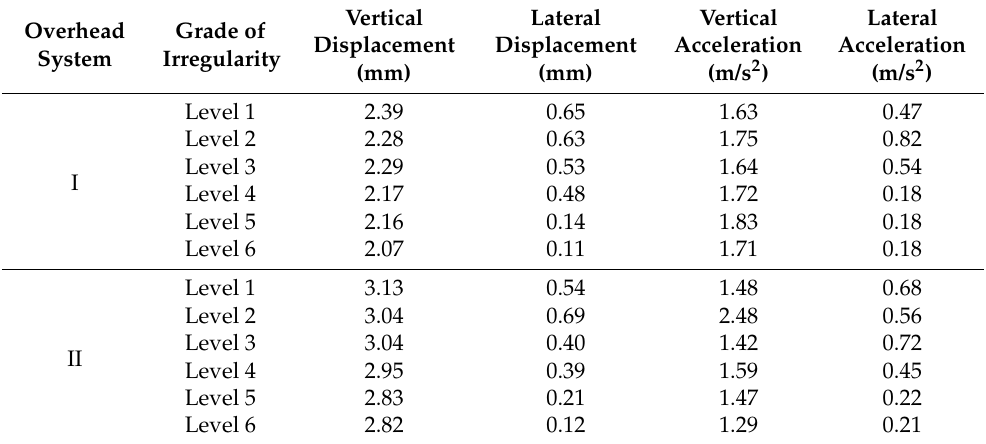
Table 8. The dynamic response of the aerial system under various track irregularity grades.